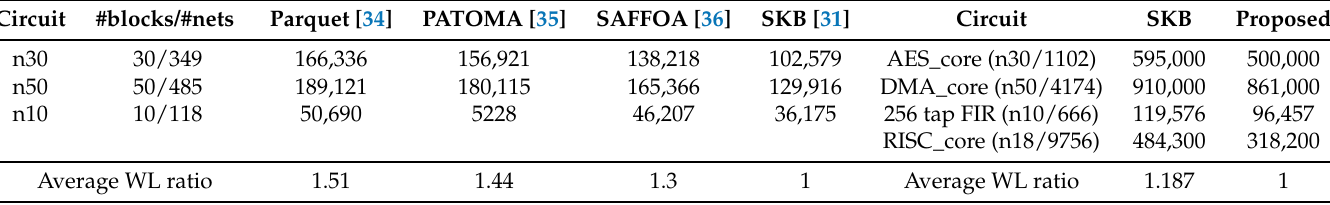
Table 3. Comparison of other floorplanners for fixed outline floorplanning.